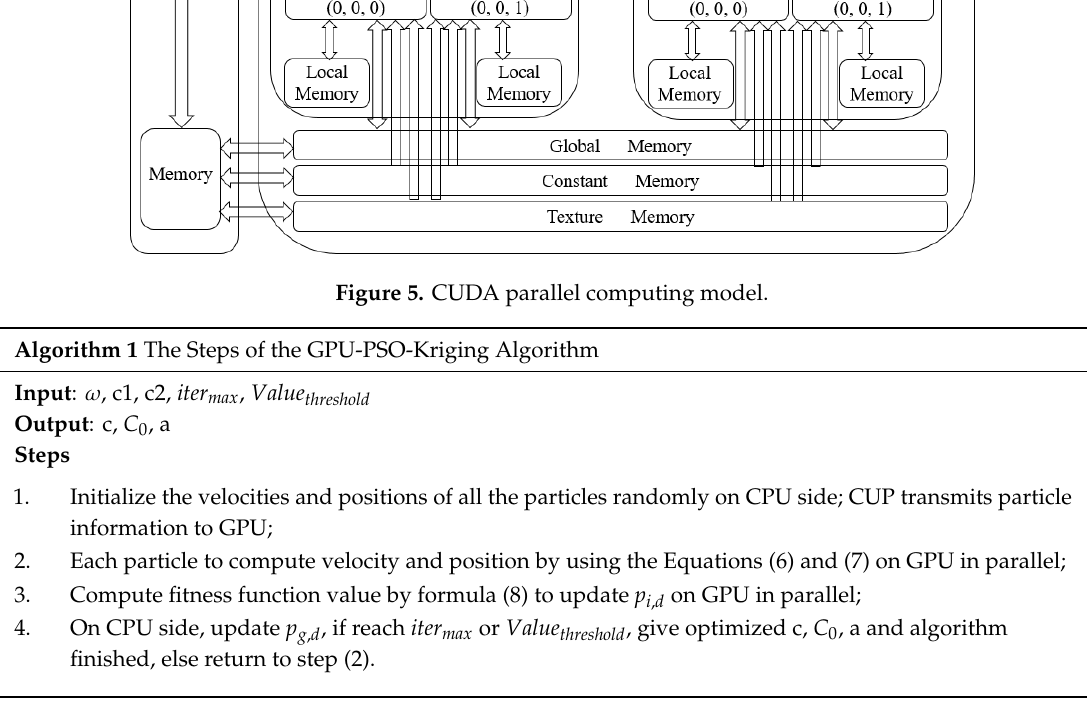
Algorithm 1 The Steps of the GPU-PSO-Kriging Algorithm